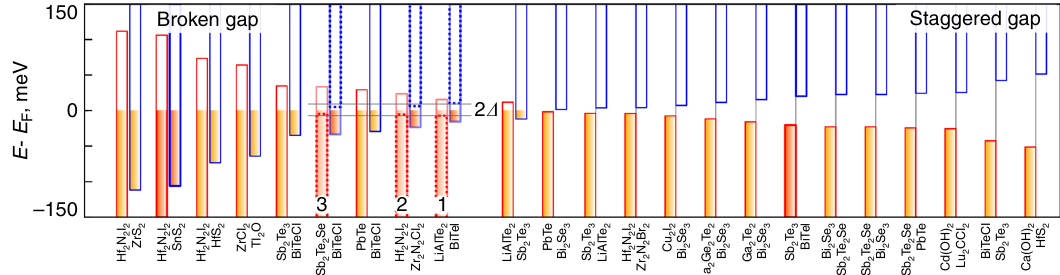
Fig. 3 Hetero-bilayers band alignments. Relative positions of valence (left upward columns) and conduction bands (right downward columns) in 2D heterostructures for Δ ε < 2%, − 0.22 eV < Δ E < 0.1 eV, E g > 0.3 eV. The fi ve bilayers considered in detail in this work are highlighted with thicker outline, and the calculated BCS gaps Δ for heterostructures 1, 2, and 3 are shown.